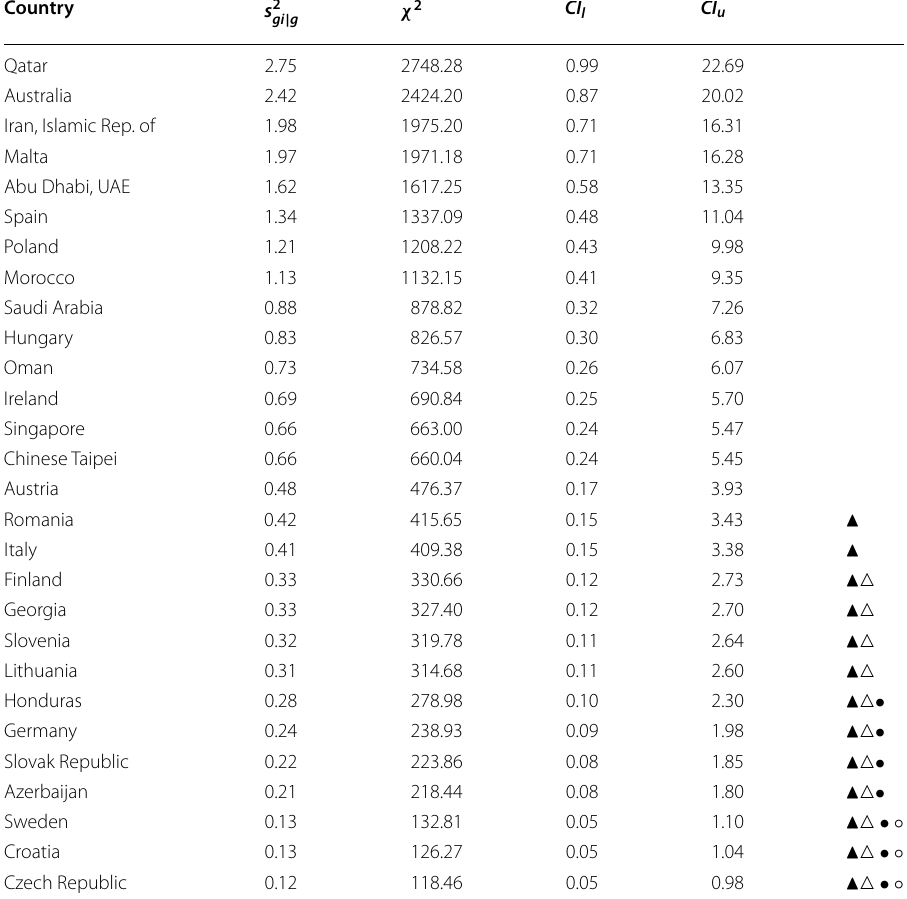
Table 7 Variance of the discrimination parameter c gi across items (given country g ), χ 2 - value and asymmetric confidence interval ( CI l lower bound, CI u upper bound; countries ordered in descending order of s 2 gi | g